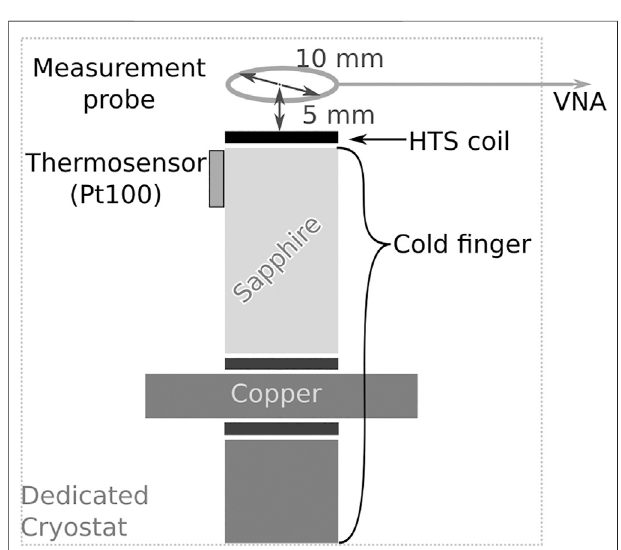
FIGURE 3 | MR images of a water sample in the vicinity of a HTS coil (A) after different cooling conditions of the coil (at 58 K), and (B) for different temperatures of the coil after zero- fi eld cooling. The slice shown is parallel to the HTS coil plane, ∼ 4.2 mm above. B data were unwrapped, resolving the 2 π -jumps. Data taken from [5].